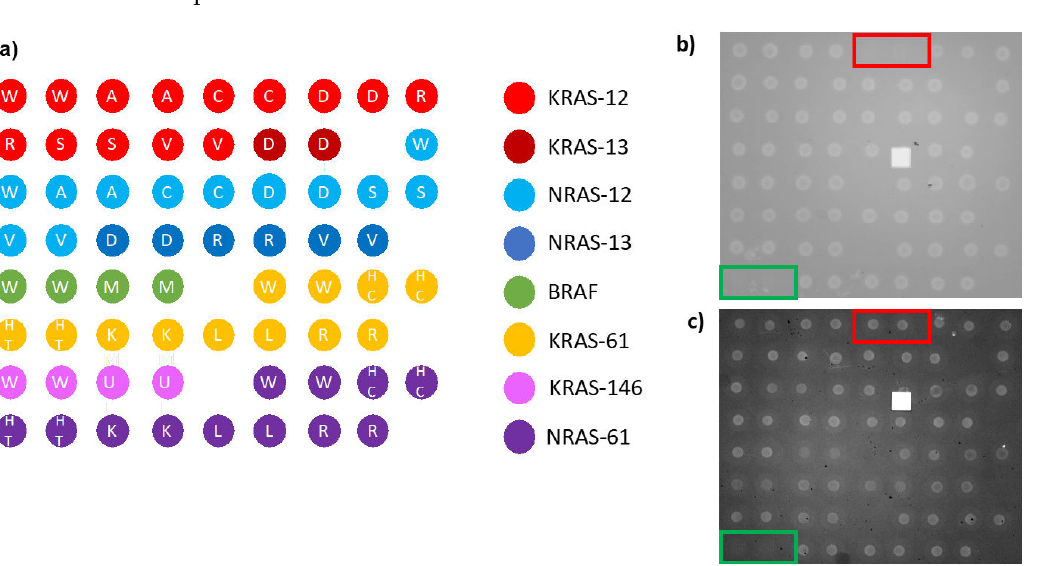
Figure 3. Scheme and images of the multiplexed chip utilized for IRIS quality control assay. ( a ) Spotting scheme of the 33 oncogene capture probes, where different colors indicate a different codon or gene. ( b ) IRIS image of a chip where KRAS-12 C (red rectangle) and NRAS-61-ht (green rectangle) were absent due to poor immobilization. ( c ) IRIS image of a new chip where immobilization for KRAS-12-C was optimized (red